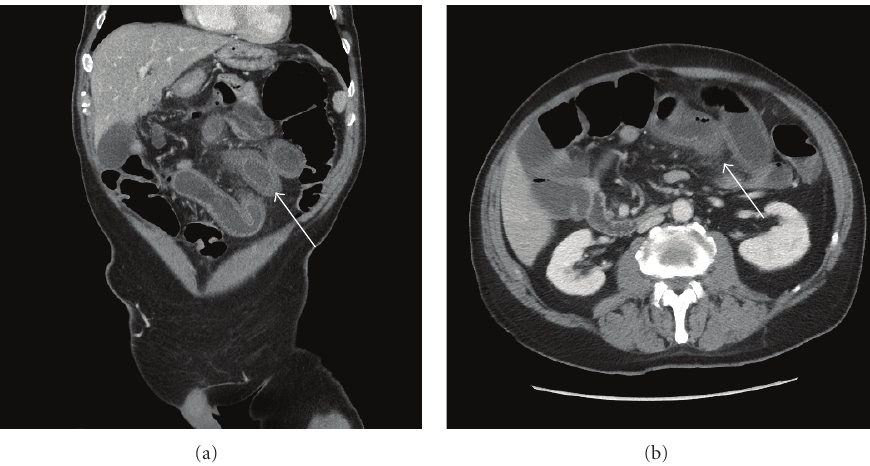
Figure 1: (a) A coronal reformatted image of the CT abdomen and pelvis demonstrating multiple dilated, fluid filled small bowel loops, with thickened and enhancing mucosa in keeping with bowel wall oedema ( Arrow ). (b) Axial images again showing thickened oedematous small bowel loops with surrounding inflammatory fat standing ( Arrow